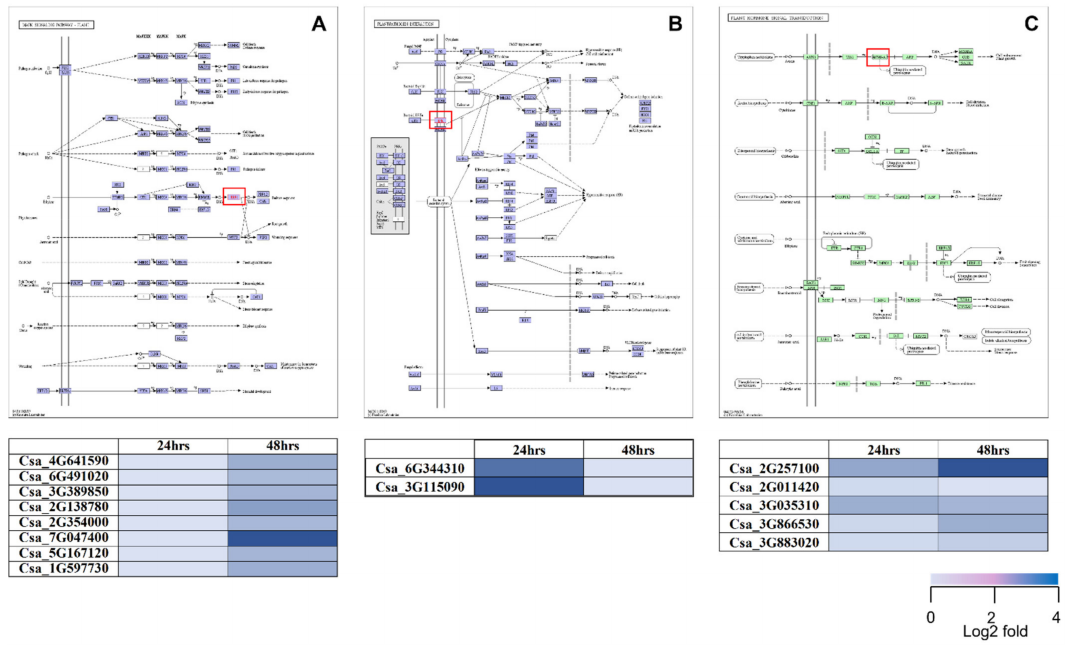
Figure 4. KEGG analysis of DEGs related to ( A ) MAPK signaling, ( B ) plant-pathogen interaction and ( C ) plant hormone signal transduction pathways. Heat maps show the expression level of DEGs involved in each KEGG pathway.